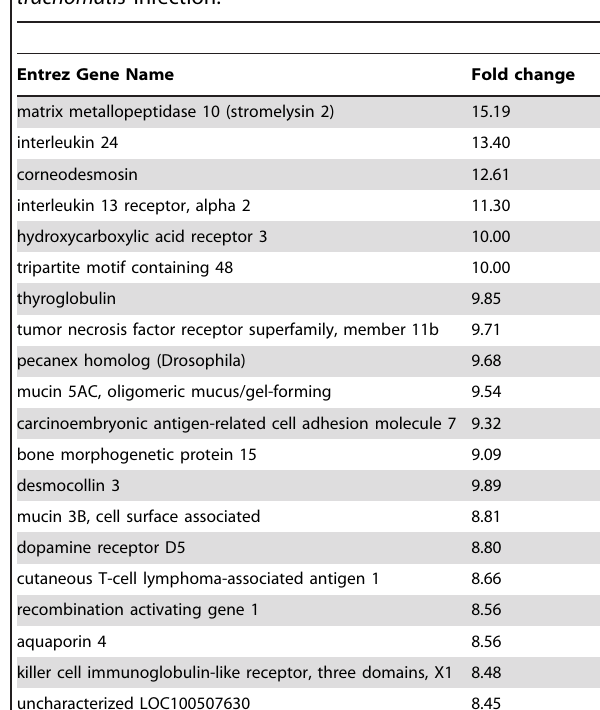
Table 2. List of the 20 molecules (and corresponding fold change) that were identified by genome-wide microarray analysis as the most intensely upregulated by endometrial C. trachomatis